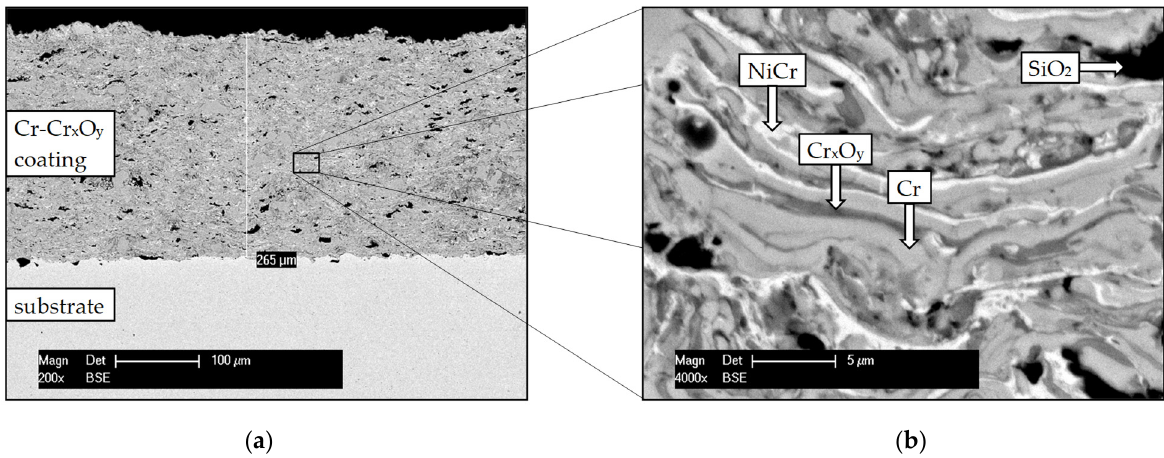
Figure 1. SEM/BSE cross-section micrographs of the as-sprayed Cr-Cr x O y coating ( a ) overview, ( b ) higher magnification.